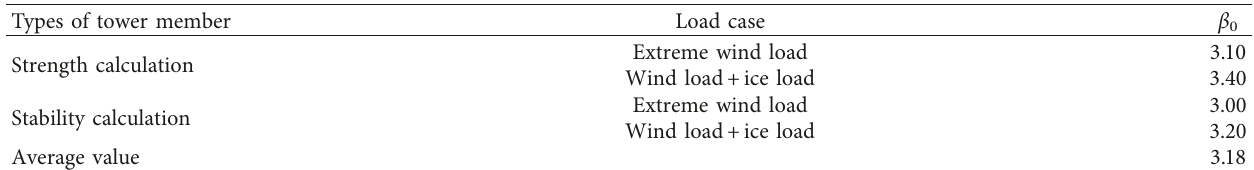
0 of transmission